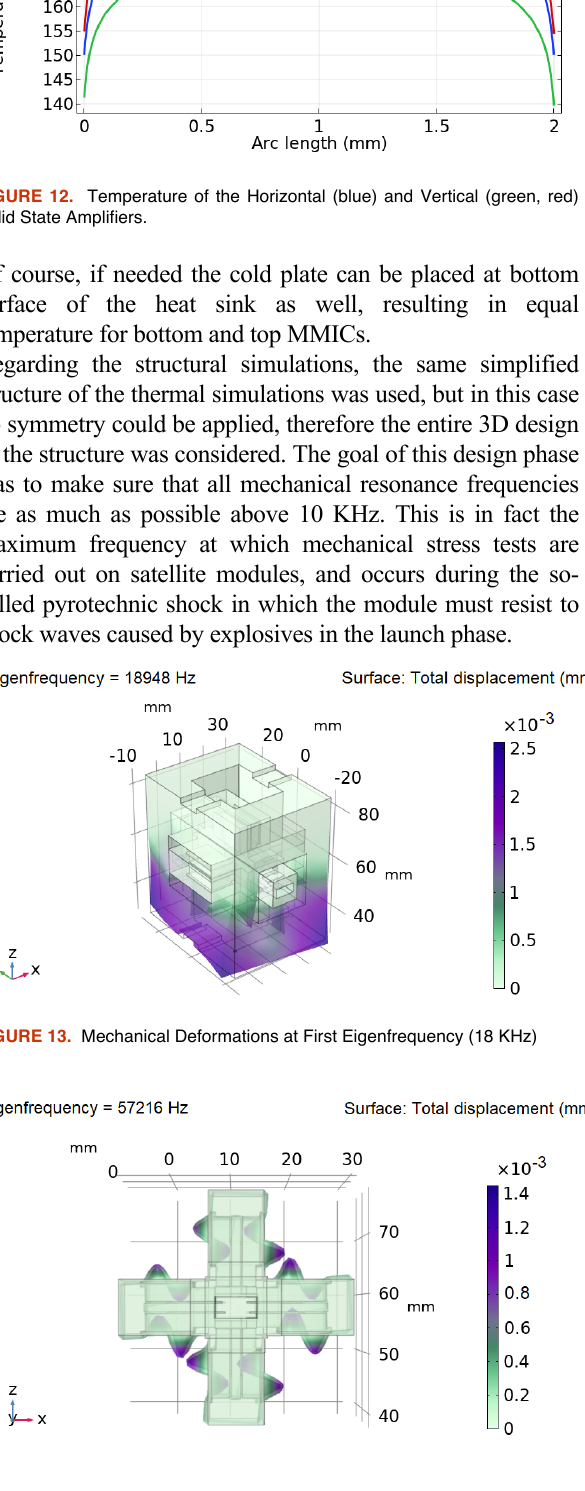
FIGURE 14. Mechanical Deformations at one of the Eigenfrequencies (57